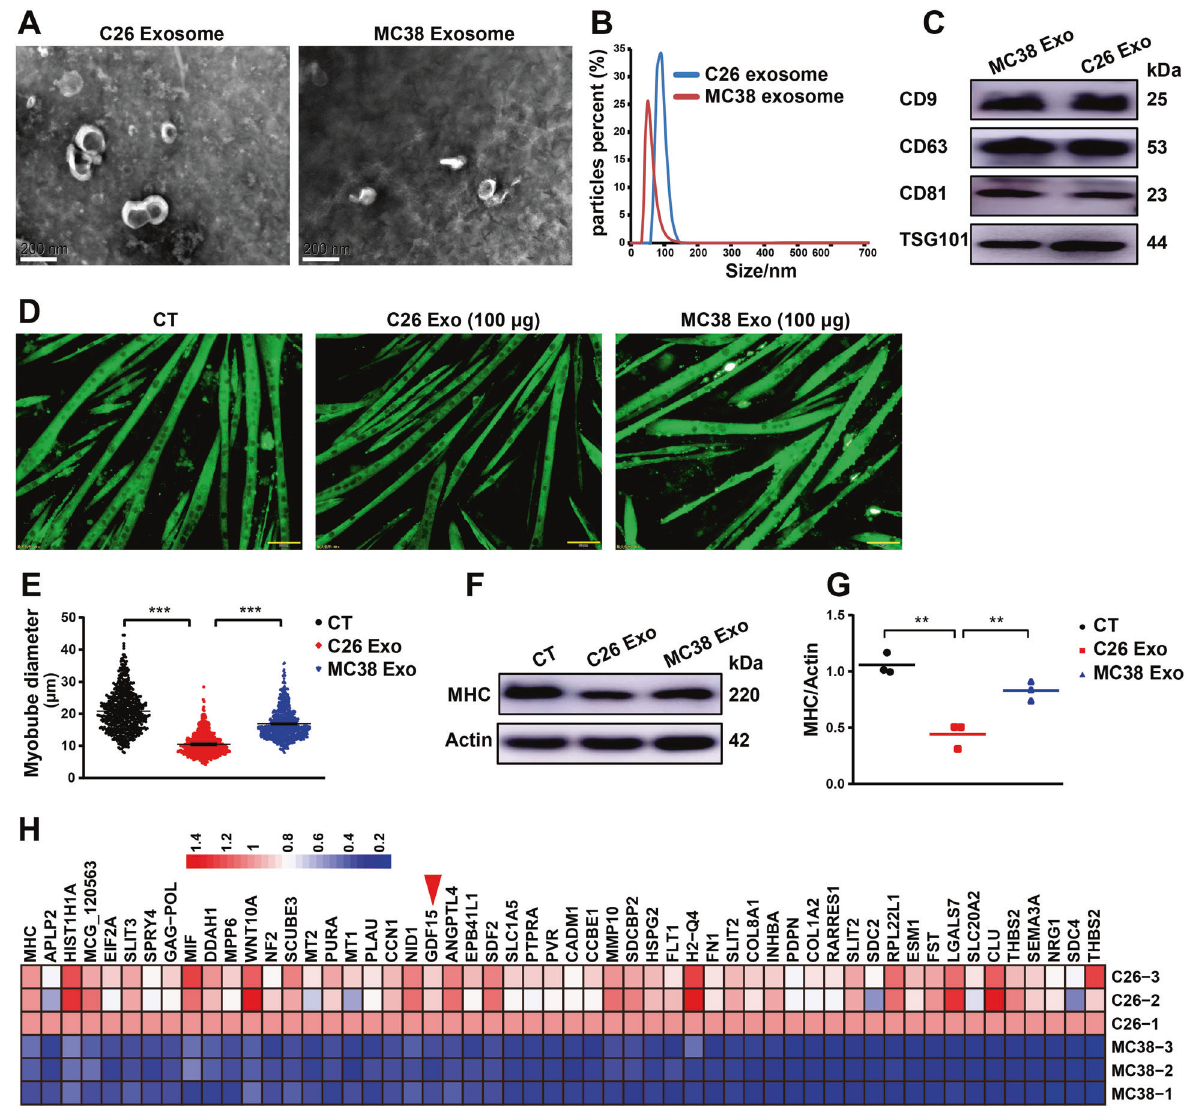
Fig. 1 Cachectic C26 exosomes contain high level of GDF15. A Representative transmission electron microscopy image of C26 and MC38 exosomes (scale bars, 200nm). B Particle size analysis of exosomes derived from C26 and MC38 cells. C Western blots showed the expression of exosome markers (CD9, CD63, CD81, TSG101). D Representative immuno fl uorescent images of C2C12 myotubes treated with exosomes (scale bars, 50 μ m). The C2C12 myotubes wasting were induced by exosomes (100 μ g) of C26 and MC38 respectively for 48 h. E Quanti fi cation of diameter of C2C12 myotubes treated with exosomes ( n = 653,653,653, *** p < 0.001; t test). F , G Western blot analysis of MHC ( n = 3, ** p < 0.01; t test). H Proteomics was performed to fi gure out the difference in protein pro fi les of C26 exosomes versus MC38 exosomes. Data presented are the mean ±